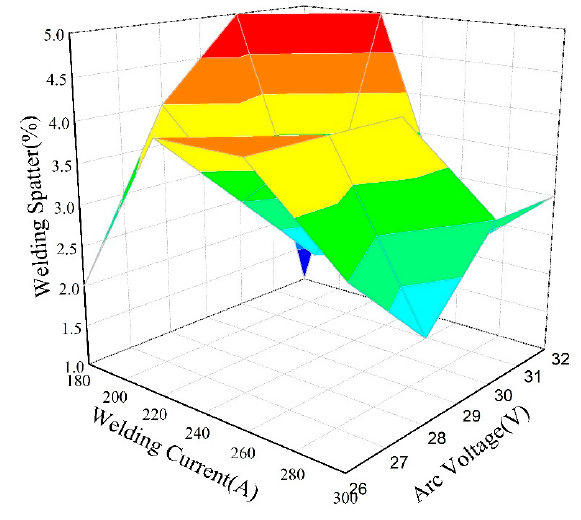
Figure 5. Interaction of welding current and arc voltage on welding spatter.